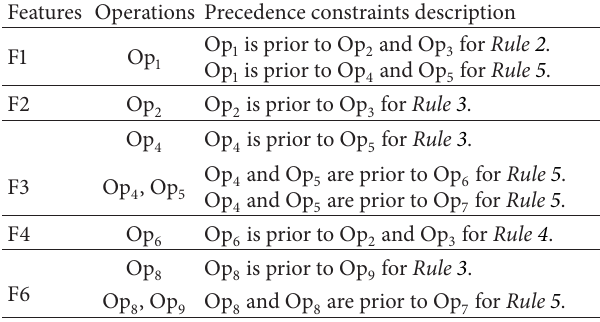
Table 2: Precedence constraints between operations. Features Operations Precedence constraints description